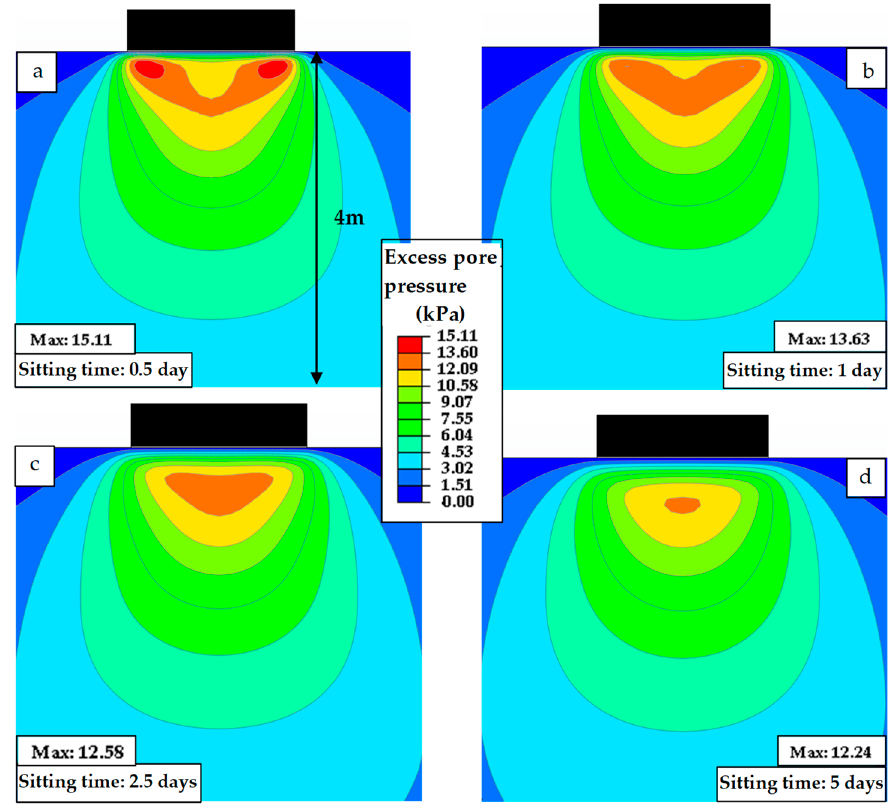
Figure 9. Distribution of the excess pore pressure after sitting for ( a ) 0.5 day, ( b ) 1 day, ( c ) 2.5 days, and ( d ) 5 days.